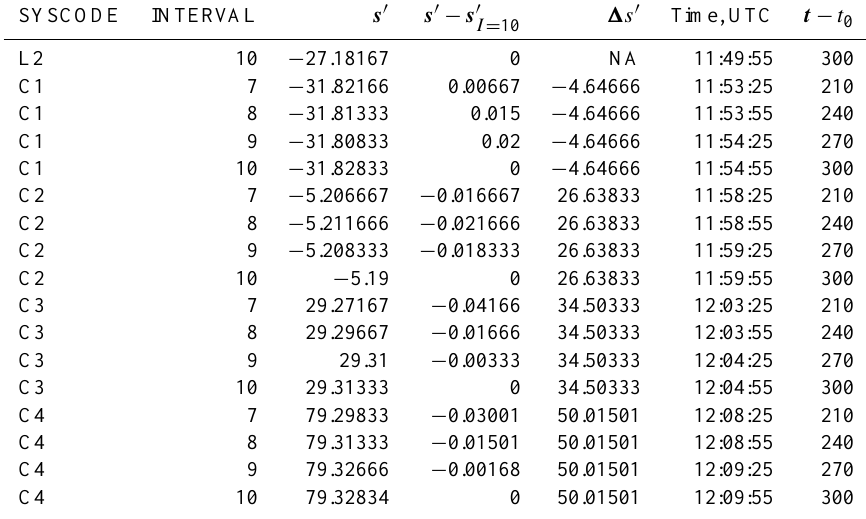
Table C1. Terms used in the disequilibrium correction for CO 2 .